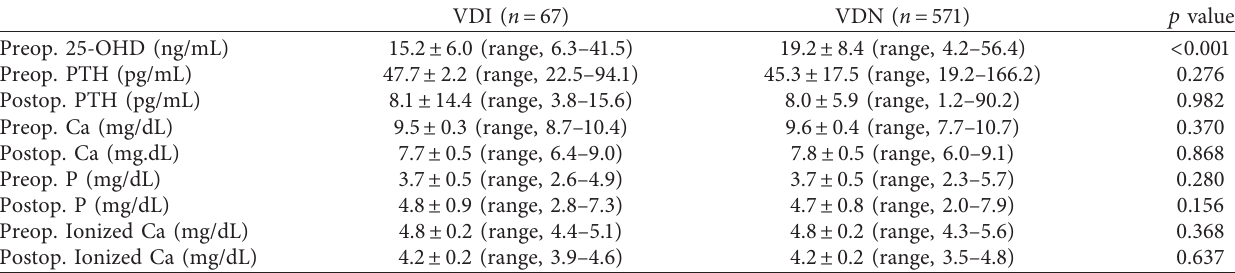
Table 4: Comparison of perioperative biochemical characteristics of patients with transient hypocalcemia between vitamin D3 injection (VDI) and vitamin D3 noninjection (VDN) groups.